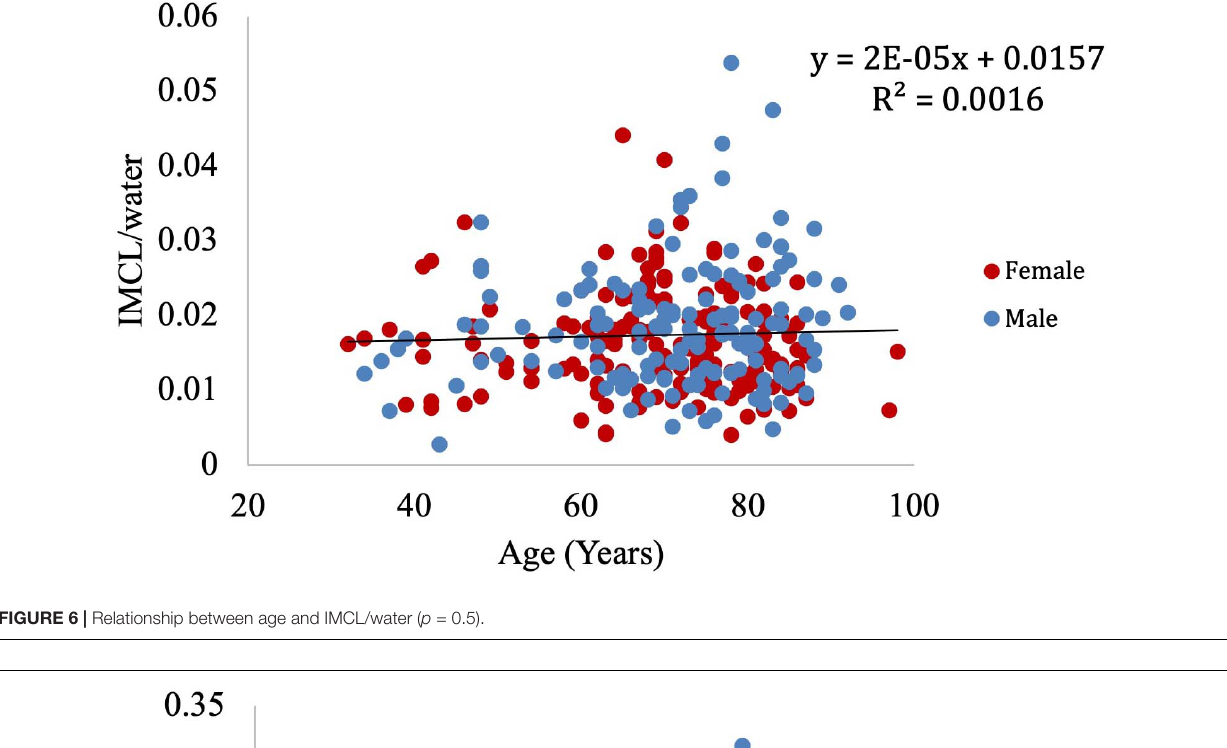
FIGURE 6 | Relationship between age and IMCL/water ( p = 0.5).